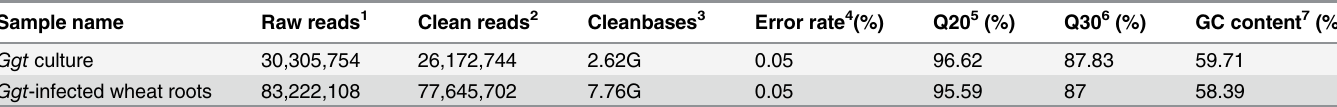
Table 1. Transcriptome statistics of cDNA libraries from 5 day old culture of Ggt and 7 day old Ggt -infected wheat